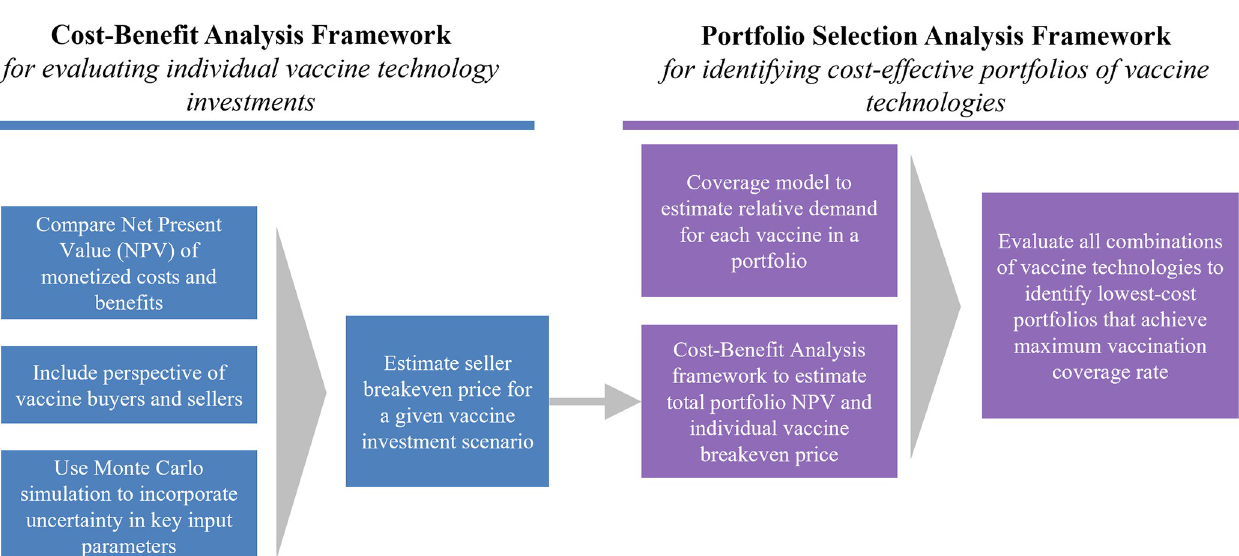
PLOS ONE | https://doi.org/10.1371/journal.pone.0283977 April 5,